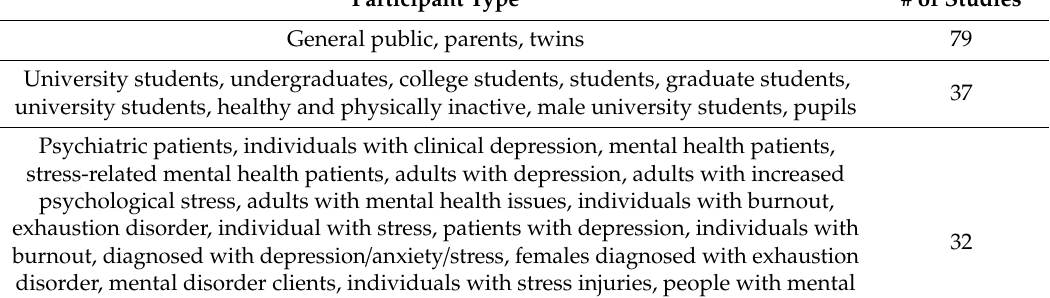
Table 5. The literature was charted based on the type of participant included in the study. Participant